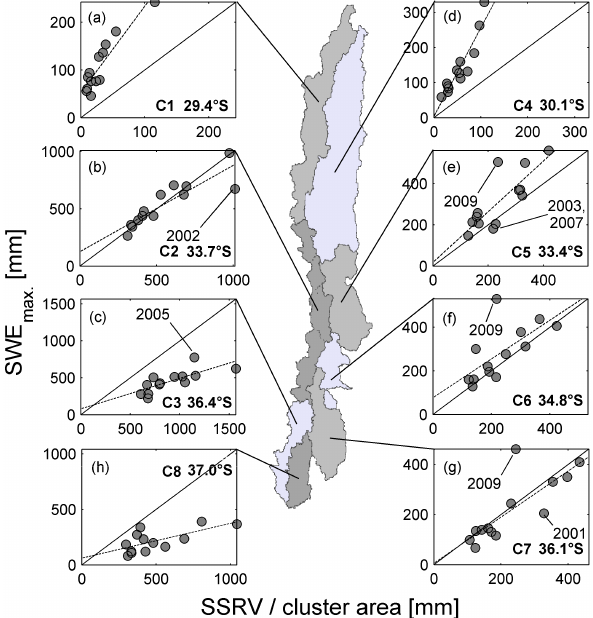
Figure 6. Area-specific spring–summer runoff volume (SSRV) ver- sus peak SWE. Clusters 1 through 3 include rivers on the Chilean (western) slope of the Andes range; clusters 4 through 8 correspond to Argentinean (eastern) rivers. Solid line represents the 1:1 line. C4 and C8 SSRV were estimated by the area-transpose